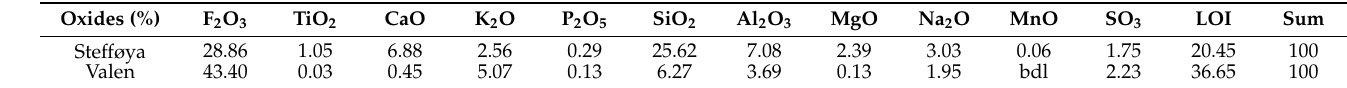
Table 1. XRD quantification (in percentage) of jarosite samples from Valen and Stefføya. bdl–below detection limit. Mineral Valen Stefføya Amphibole bdl 12 Gypsum 3 11 Jarosite 95 66 Potassium feldspar bdl 9 Quartz 2 2 Table 2. XRF quantification (in percentage) of jarosite samples from Valen and Stefføya. bdl—below detection limit; LOI—loss on